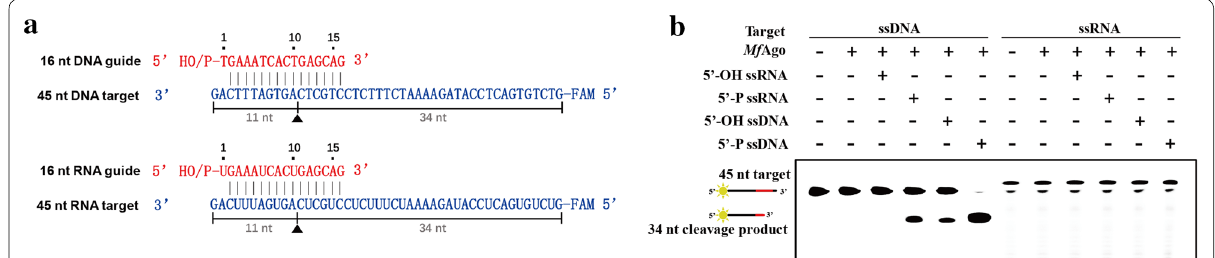
Fig. 3 Endonuclease activity assays of Mf Ago in vitro. a Synthetic DNA or RNA guides (red) and targets (blue). Predicted cleavage positions are indicated with a black triangle, black lines indicate the predicted 11- and 34-nt cleavage products. b Cleavage activity assay of Mf Ago with FAM-labeled DNA or RNA targets